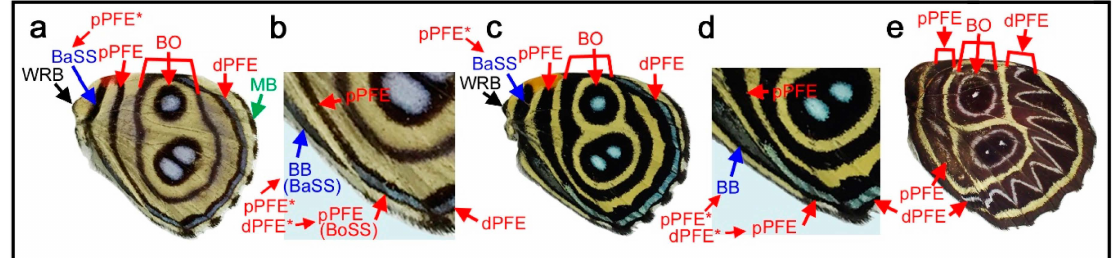
Figure 8. Three Callicore species with more complex patterns. Alternative identifications are indicated by asterisks. ( a ) Callicore hystaspes . ( b ) The tornus of the wing shown in a. ( c ) Callicore eunomia . ( d ) The tornus of the wing shown in c. ( e ) Callicore sorana